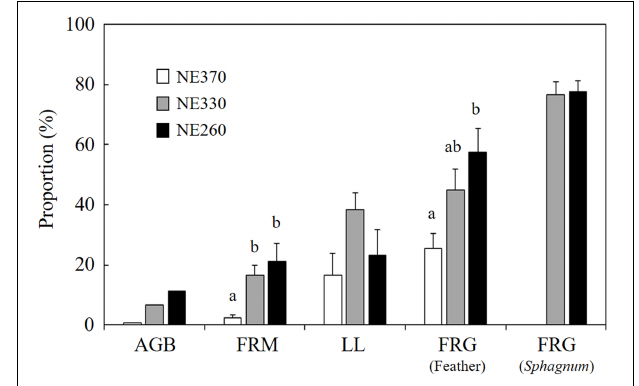
FIGURE 6 | Proportion of understory plants in total (black spruce + understory) aboveground biomass (AGB), fine root mass (FRM), leaf litter production (LLP), and fine root growth (FRG) in feather and Sphagnum -moss substrates. White, gray, and black columns represent data from NE360, NE330, and NE260 plots, respectively. Data shown are mean + SE (AGB, N = 1; LLP, N = 7–8; FRM and FRG, N = 9). Different alphabetical letters indicate significant difference between the plots within each of the above and belowground parameters (Tukey–Kramer HSD